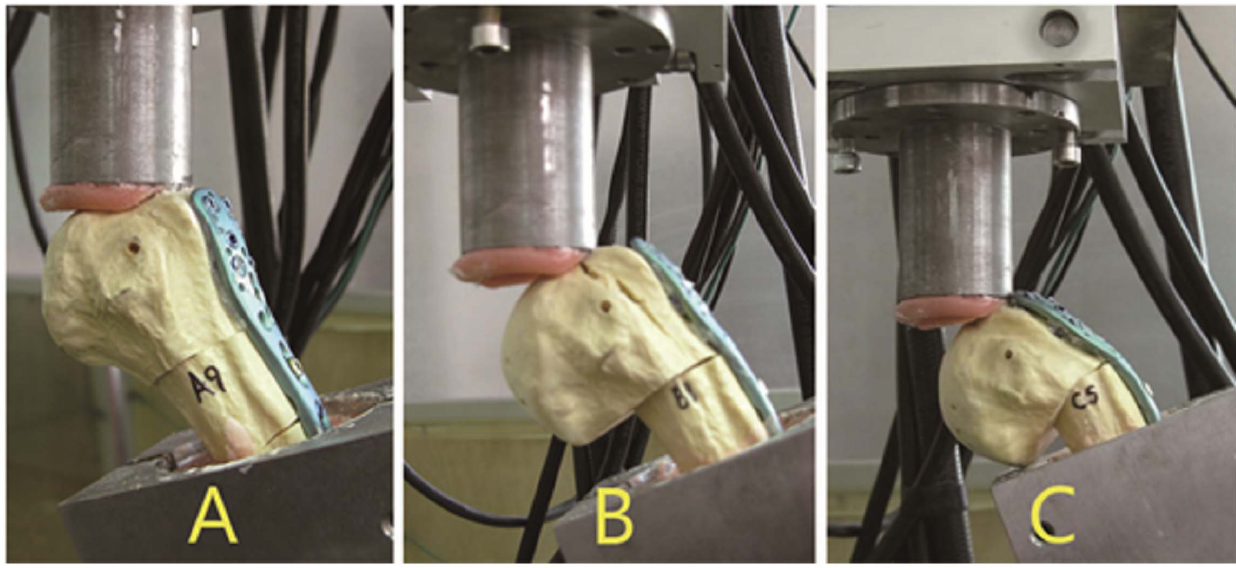
Figure 5. Shear Failure Mode: humeral shaft fracture (A), humeral head fracture (B) and specimens failed by significant plate bending (C).